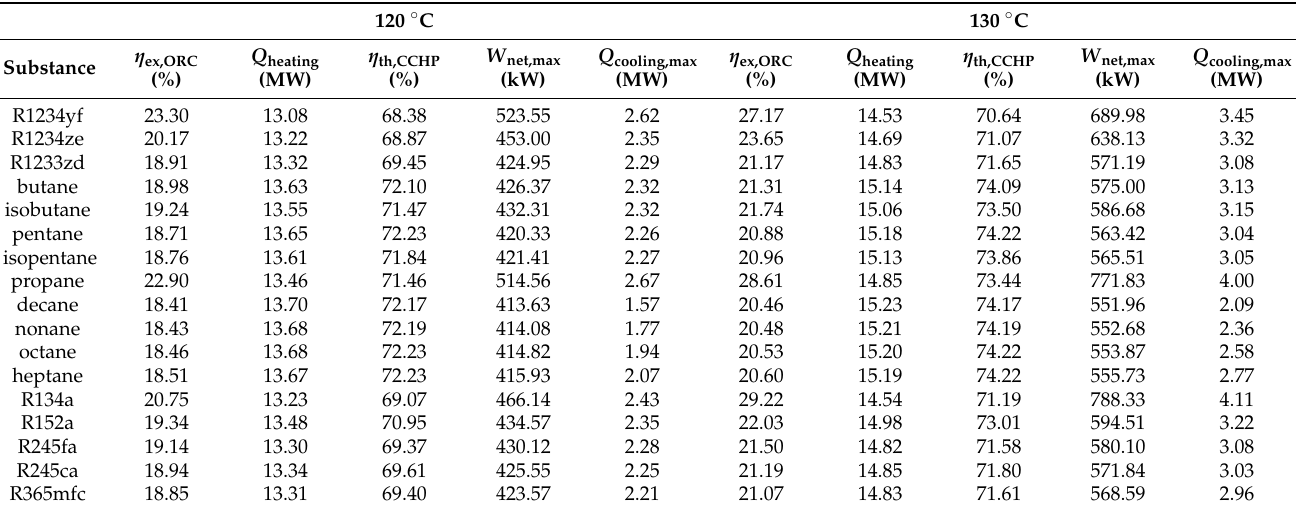
Table 6. Performance comparison of working fluids at temperature of geothermal fluid is 120 and 130 ◦